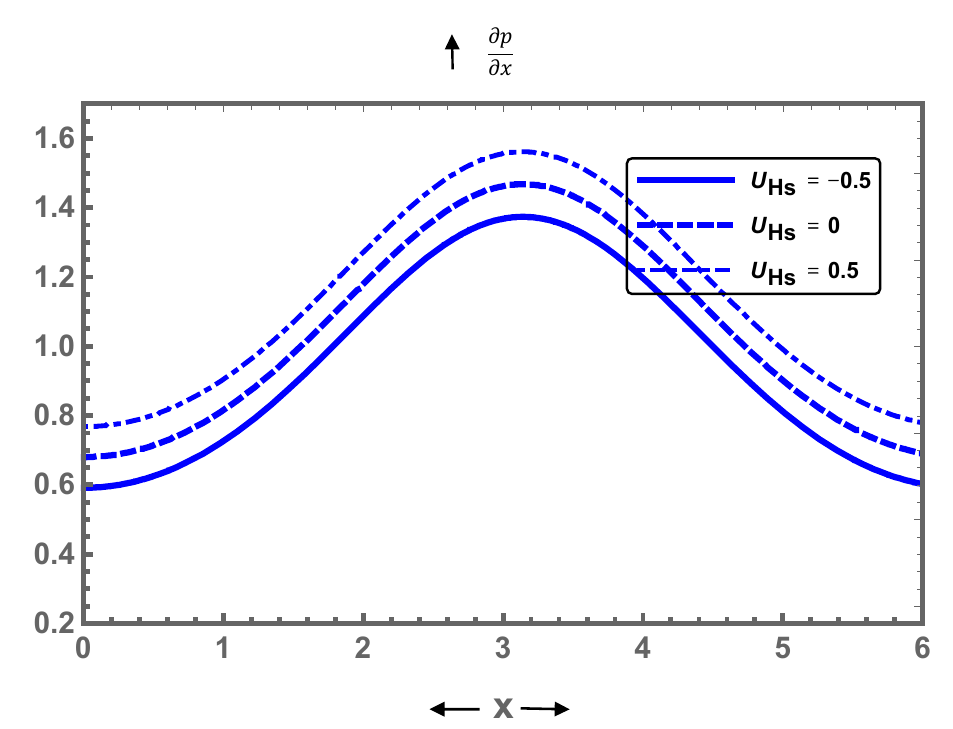
Figure 18. Display of pressure gradient for different values of C .